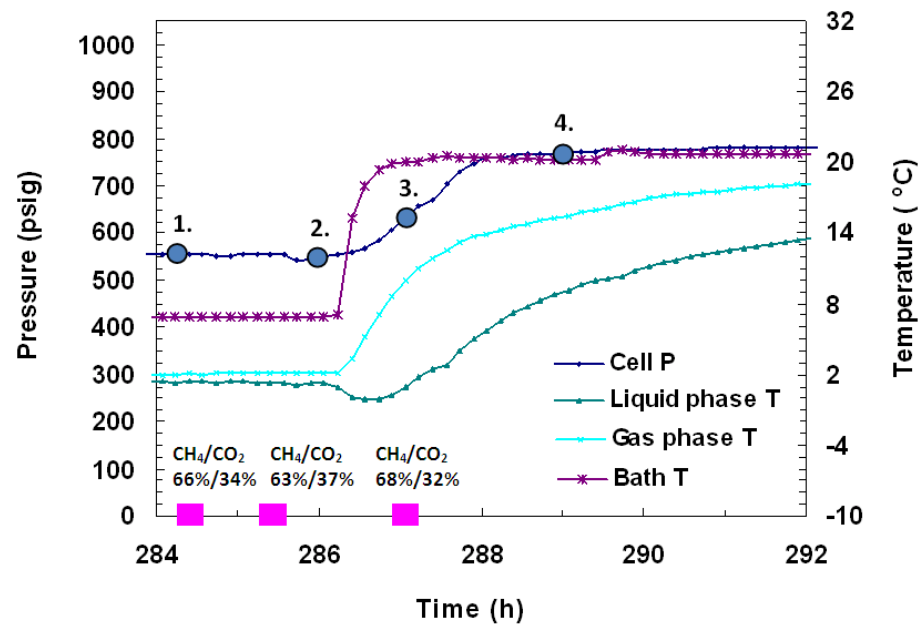
Figure 9. P/T against time during dissociation by thermal stimulation in Run 4. Hydrate formation was achieved from a CH represent gas compositions measured from gas samples analyzed in a Gow-Mac 580 series gas